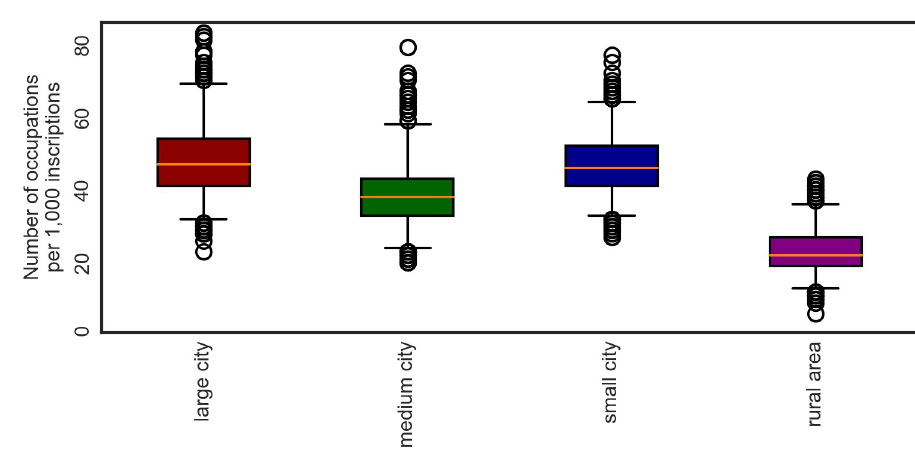
Fig 1. Occupations across urban contexts. The plots depict results of 1,000 bootstrapping cycles. Boxes correspond to inner quartiles and whiskers to 95% confidence